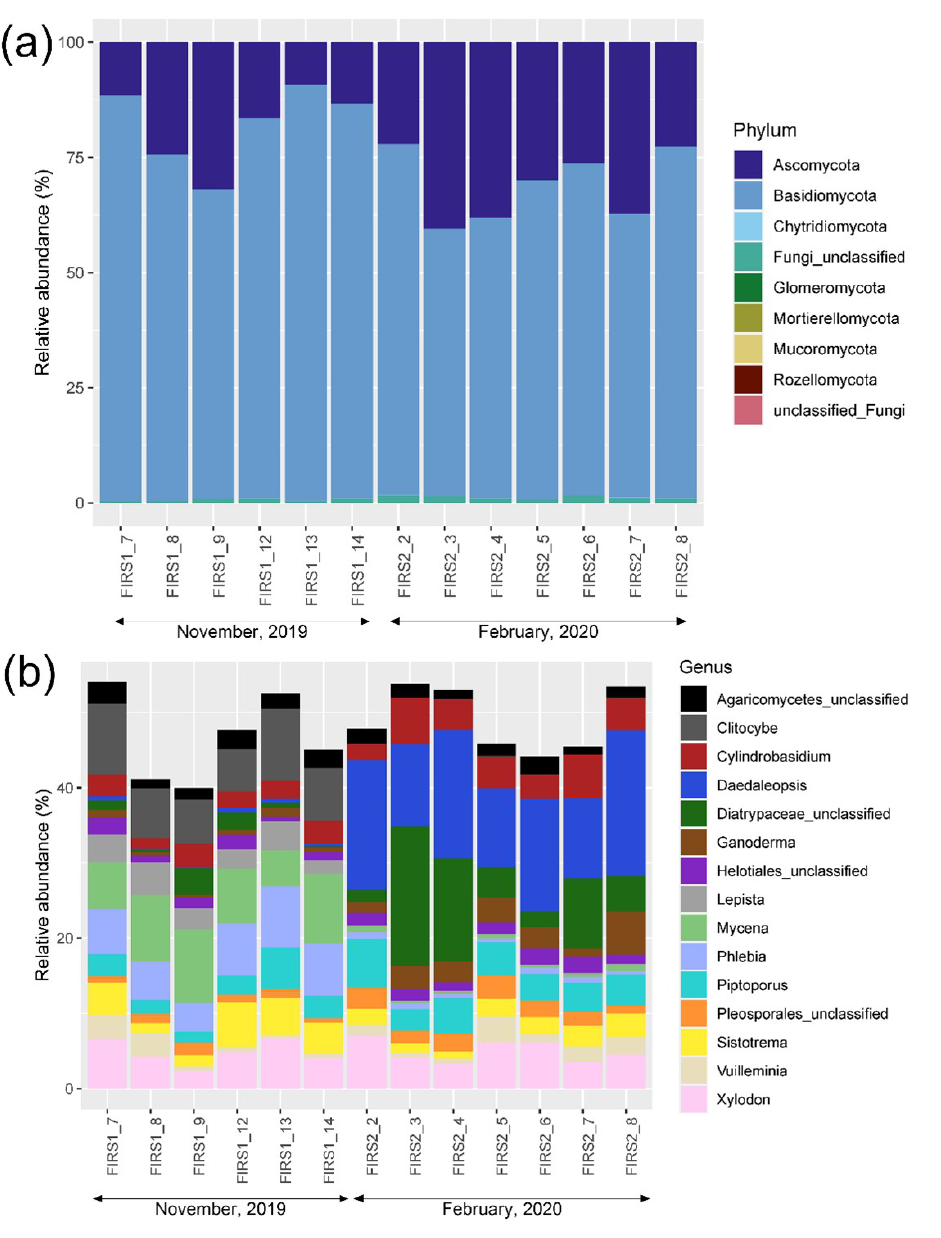
Figure 6. The 15 most abundant fungal phyla ( a ) and genera ( b ) in the